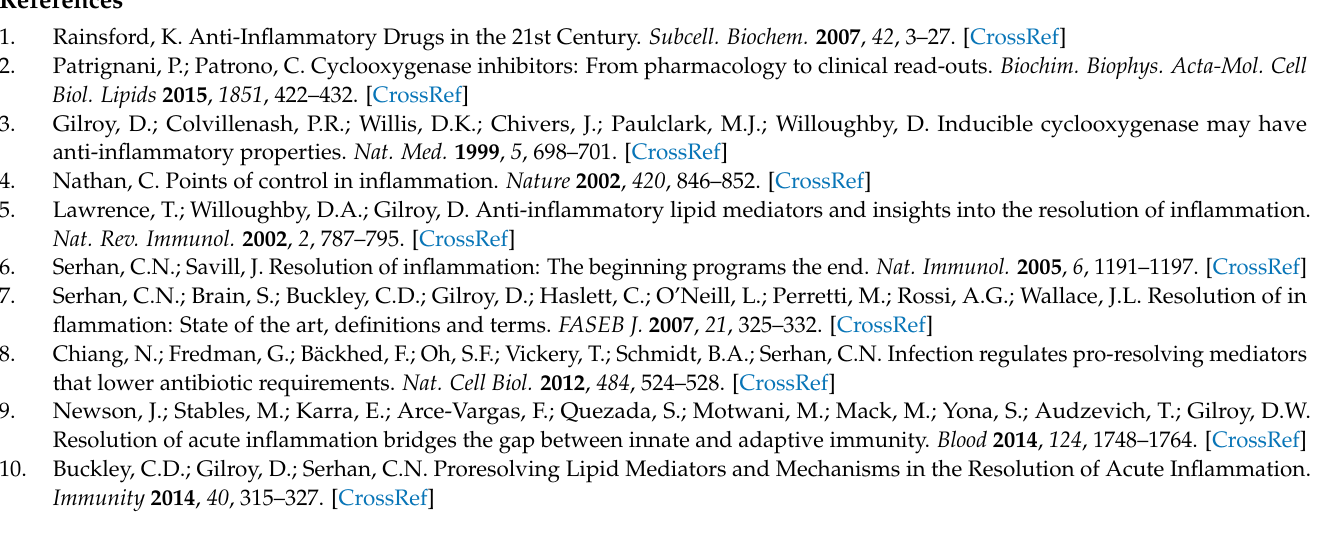
as mean ± SEM; ** p < 0.01; p values were calculated versus vehicle for each time point; unpaired two-way ANOVA with Dunnett ´ s multiple com-parison test. Figure S4: (A) Cytotoxicity of Tr14. Human naïve MDM (M GM-CSF and M M-CSF , 1 × 10 5 ) were incubated with different concentrations of Tr14 or 0.9% NaCl as vehicle or 1 µ M staurosporine (Stsp.) as positive control and polarized for 48 h with LPS/IFN γ to M1- and with IL-4 to M2-MDM at 37 ◦ C. M1- and M2-MDM were then incubated with MTT (5 mg/mL, 20 µ L) for 2 h at 37 ◦ C. The formazan product was solubilized with SDS (10% in 20 mM HCl) and the absorbance was measured at 570 nm. Results are given in % of control (0.9% NaCl), n = 3. (B) Human MDM were preincubated with 0.1 or 10% of Tr14 or vehicle (0.9% NaCl solution) for 15 min and then polarized for 48 h with IL-4 to M2-MDM. Then, cells were incubated with S. aureus (LS1; ratio 1:50) in PBS pH 7.4 containing 1 mM CaCl 2 for another 180 min. Formed LM were extracted from the supernatants and analyzed by UPLC-MS-MS, and are given as means in pg/2 × 10 6 cells ± SEM and % of vehicle is shown in a heat map; n = 3 separate donors. Table S1: Composition of Traumeel (Tr14), solution for